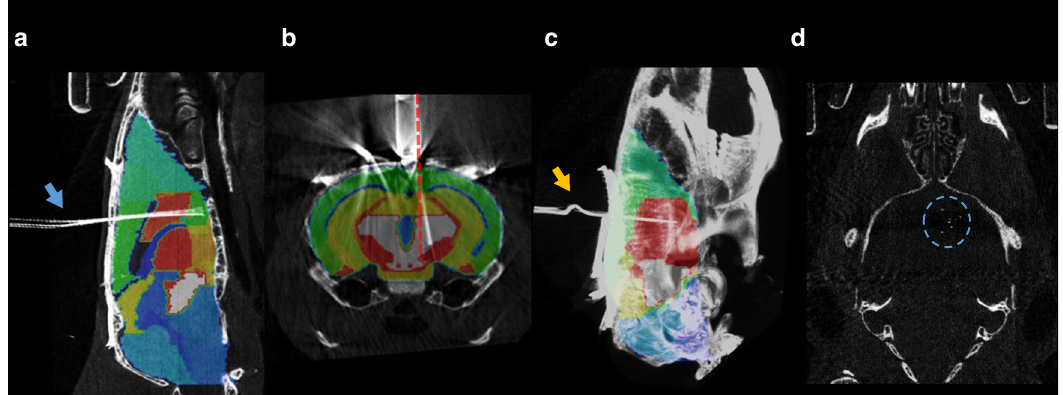
Fig. 9 Modes of failure revealed by the in vivo localization. a Bending of the tetrode bundle (blue arrow). b Tetrode bundle not parallel with the cannula (red dashed line, the cannula was aligned with the dorsoventral direction during the stereotaxic surgery). c Kink on the tetrodes outside the brain (yellow arrow). d Overdispersion of the tetrodes, covering multiple adjacent brain areas (blue dashed circle). CT images are shown in